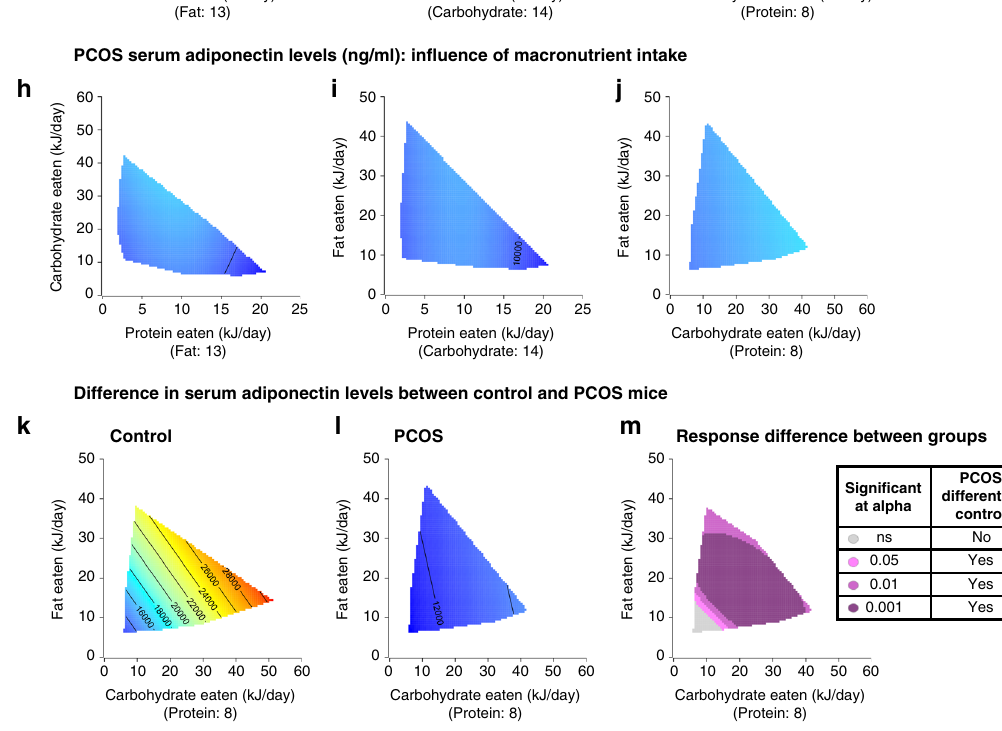
structured exercise training and hypocaloric dietary intervention cycling and ovulation for infertile women with PCOS. In a pre- alone or together with clomiphene citrate in overweight women vious study comparing the use of medical treatment (clomiphene with PCOS, the lifestyle intervention alone signi fi cantly improved citrate, metformin) vs. lifestyle modi fi cation (reduction in energy the metabolic and endocrine pro fi le, and ovulation rate when in intake and an increase in physical activity) in patients with PCOS, combination with clomiphene citrate 36 . However, these studies it was observed that lifestyle modi fi cation effectively improved do not take into account macronutrient balance and at present rates of menstrual cycles and clinical pregnancies to levels com- there is a paucity of high quality literature in this area, hindering parable with those reported in the clomiphene citrate and met- the development of testable nutritional strategies to be translated formin treated women 35 . Furthermore, in another study using a NATURE COMMUNICATIONS| (2020) 11:5262